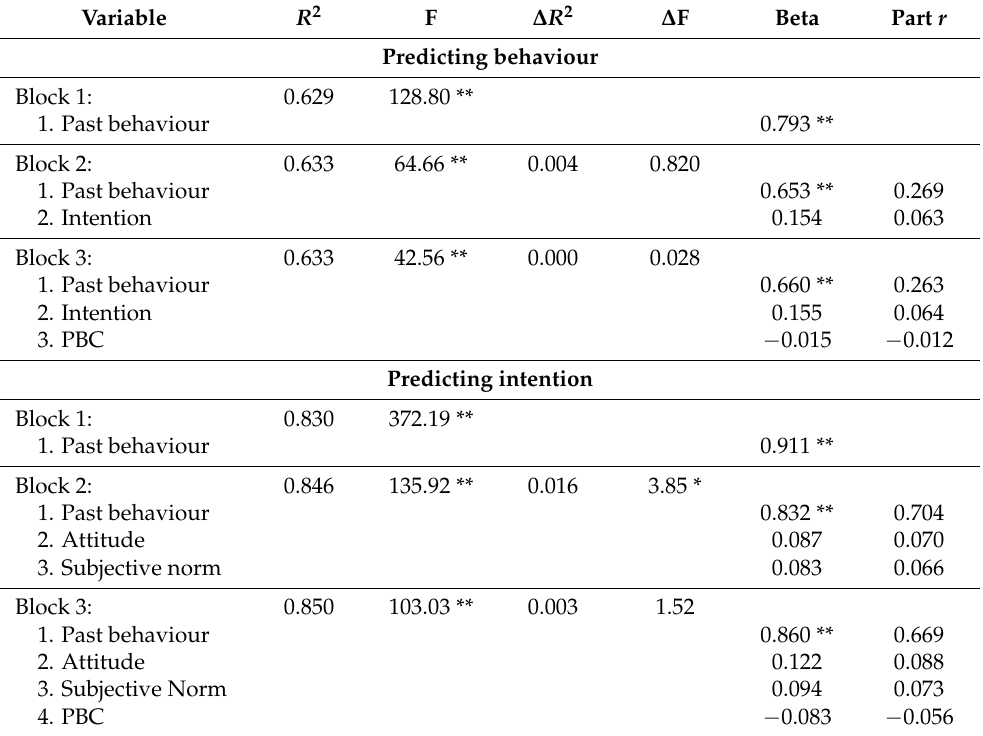
Table 8. HRA for TPB when controlling for past